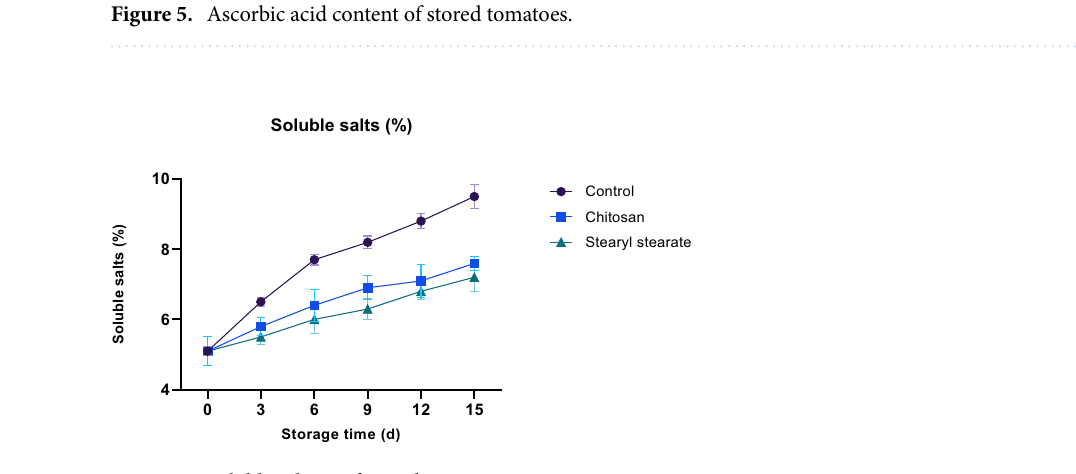
Figure 6. Soluble salts % of stored tomatoes.